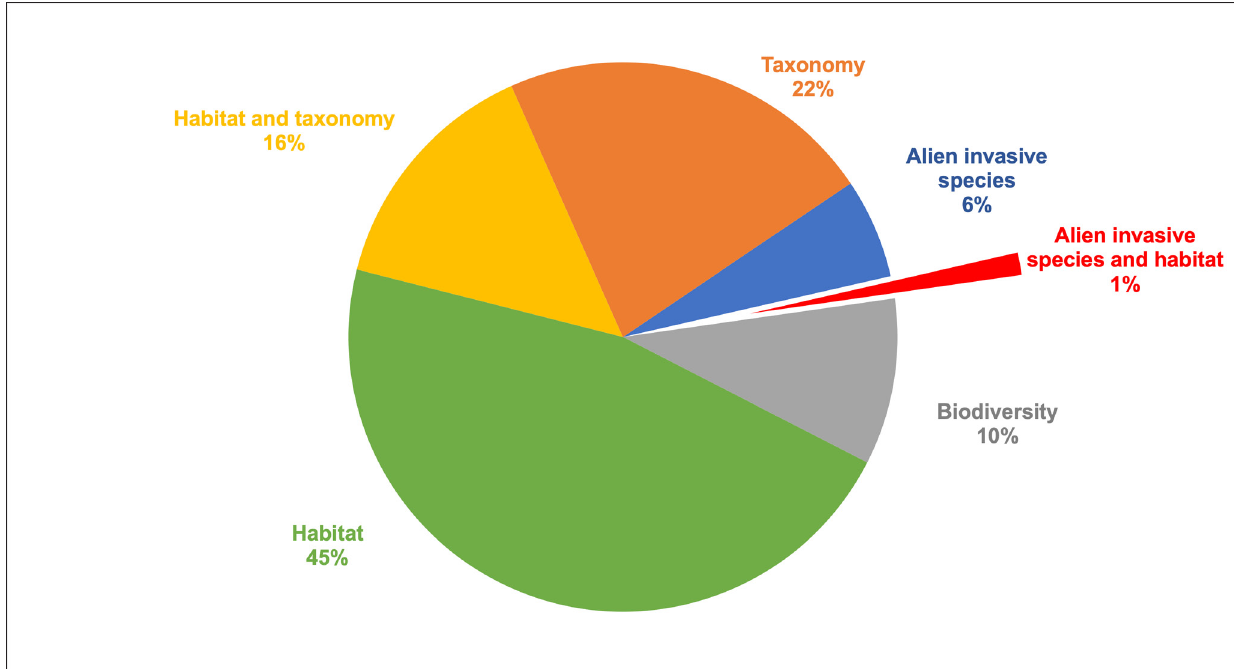
Figure 1 Summary of aquatic citizen science projects and their programme focus (n =